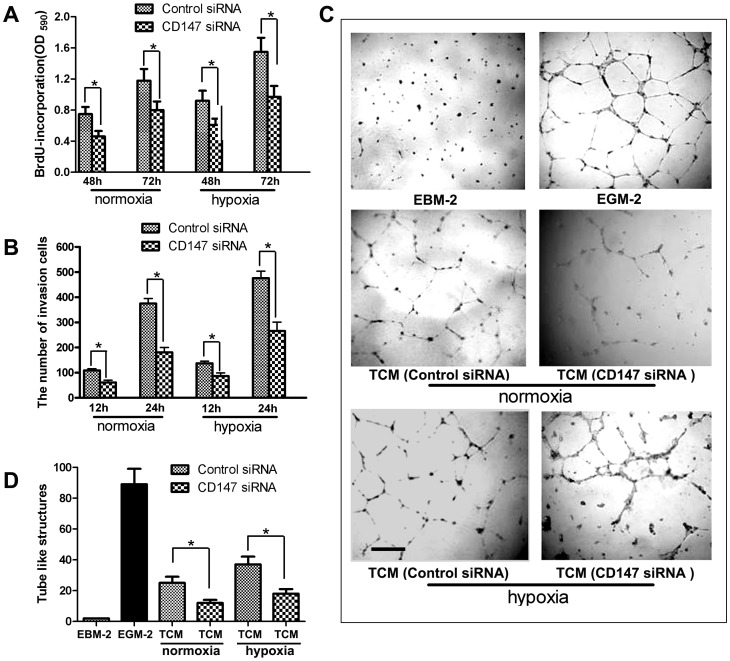
HUVEC proliferation, migration and formation of capillary-like structures were assessed.HUVECs were cultured with TCMs obtained from SMMC-7221 cells transfected with CD147 siRNA or control siRNA in either normoxia or hypoxia conditions for 24 h. (A) HUVECs proliferation was measured using the BrdU incorporation assay. HUVECs were cultured with these TCMs for 3days. The data were presented as absorbance at 490 nm (mean ± SD of three replicate experiments). *P<0.05, compared with the control level. (B) The migration ability of HUVECs was examined by the in vitro invasion assay. Cells were first planted on the upper compartment of the Boyden chambers; the lower compartment was filled with various TCMs. After 12h and 24 h of incubation, the number of cells migrating through the filter was counted and plotted as the mean number of migrating cells in an optic field in three independent experiments. *P<0.05, compared with the control level. (C) and (D) The formation of capillary-like structures were induced in different TCMs. HUVECs were seeded on top of the Matrigel and cultured for 4 h with TCMs which were mixed with EBM-2 in a 1∶1 ratio. The formation of capillary-like structures was photographed in (C), and Semi-quantitative assessment of tube formation was performed by counting the number of branches per field. *P<0.05, compared with the control level.